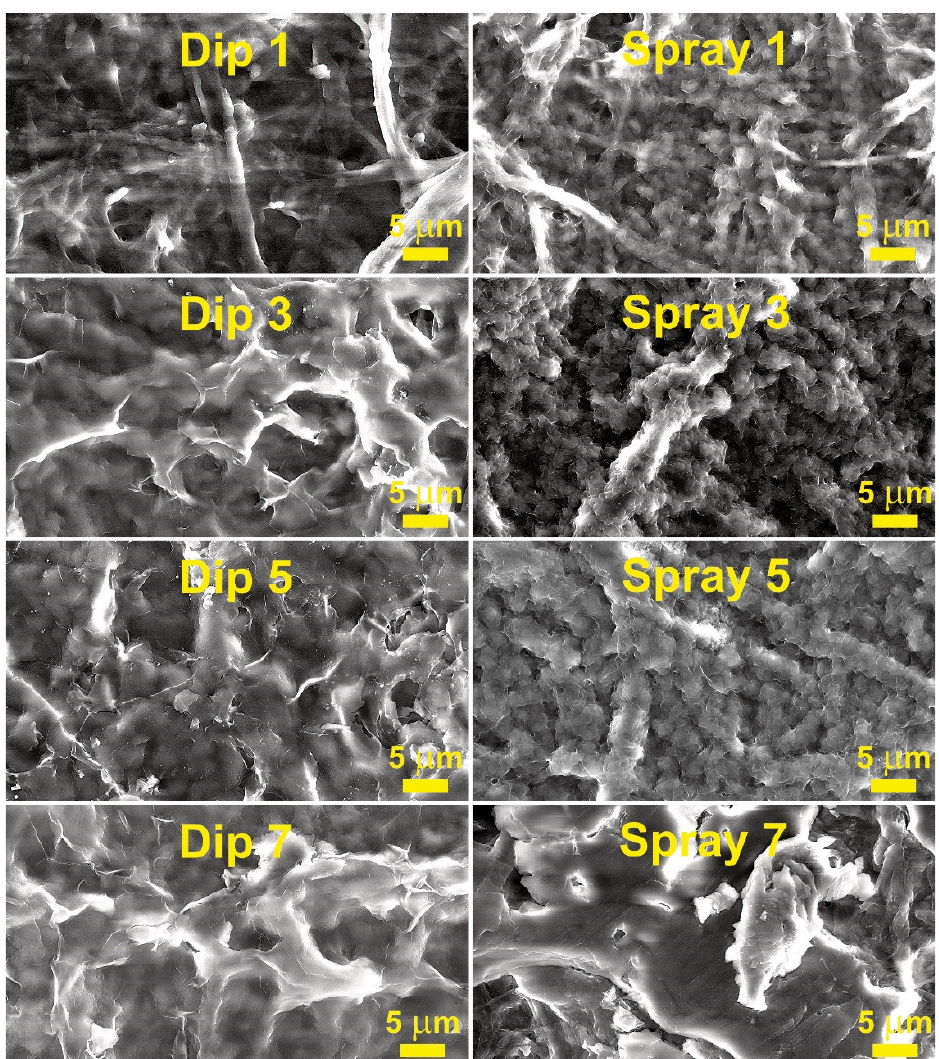
Figure 4. SEM micrographs of CNP surface with 1, 3, 5, and 7 layers of coatings applied by dip- or spray-coating methods using 1.0 wt.% wax solutions. spray-coating methods using 1.0 wt.% wax